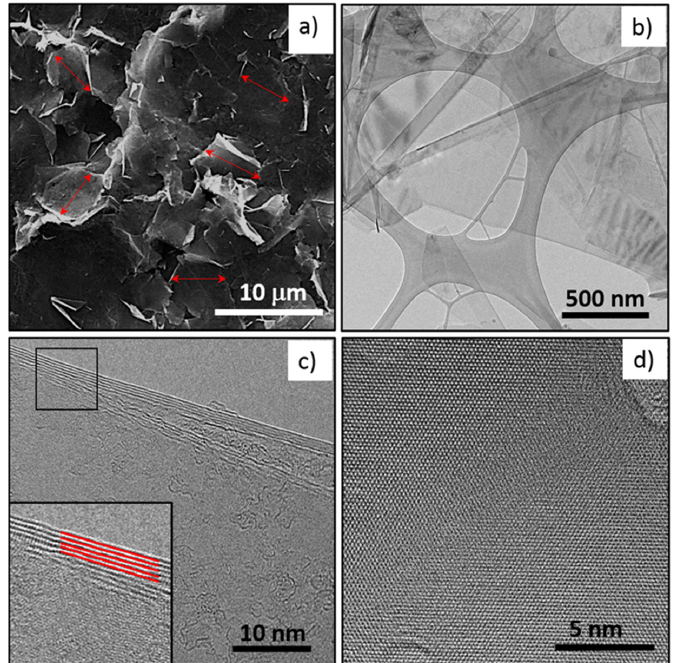
Figure 1. SEM and TEM observations of the used few-layer graphene (FLG). ( a ) SEM image, ( b ), ( c ) and ( d ) TEM images at different magnifications. TEM images at di ff erent